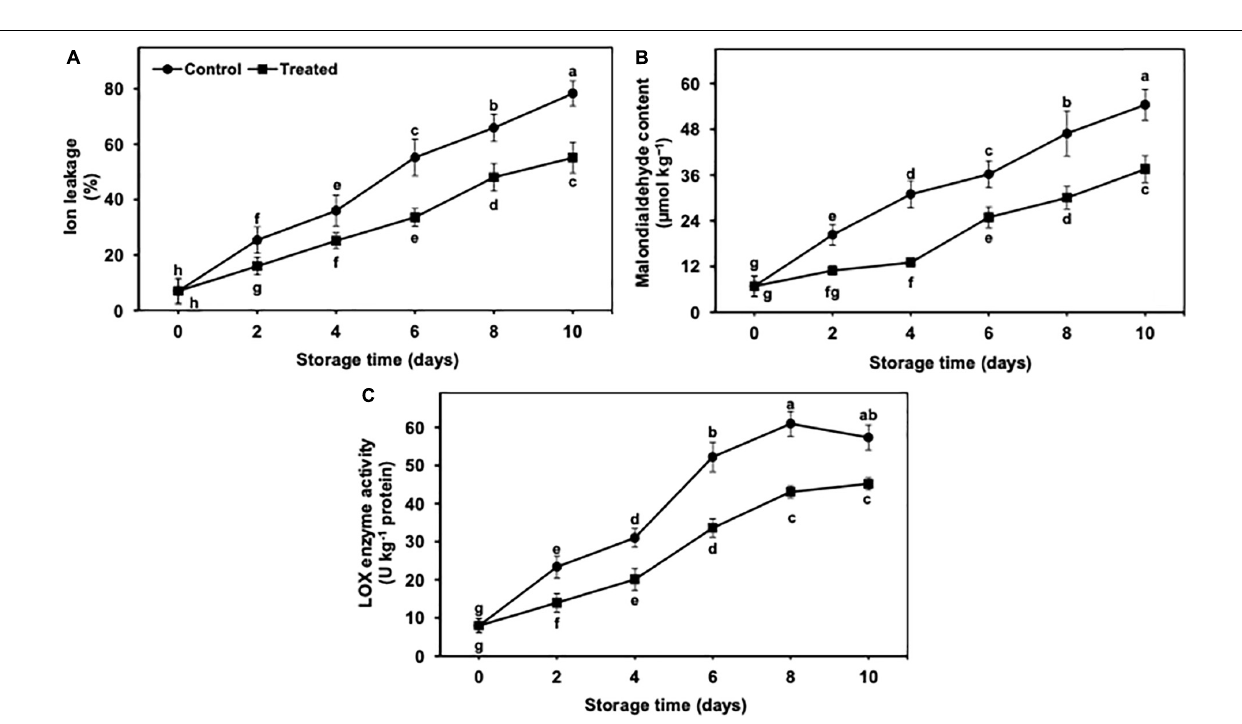
Frontiers in Plant Science |